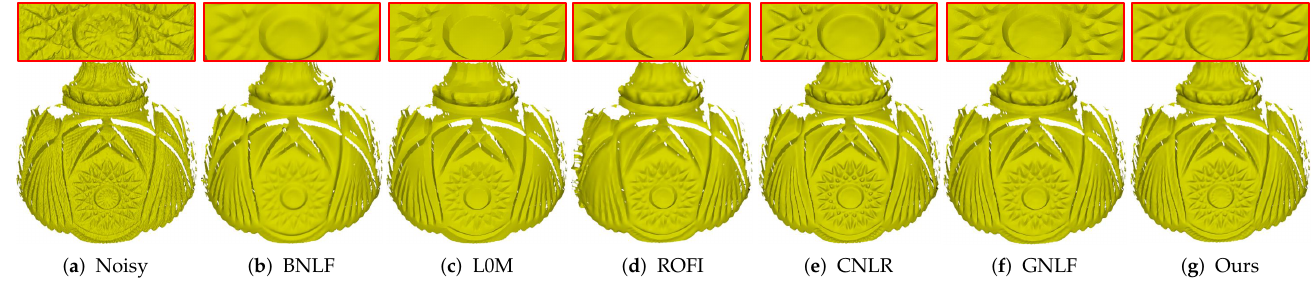
Figure 7. Denoising results of a laser-scanned mesh.